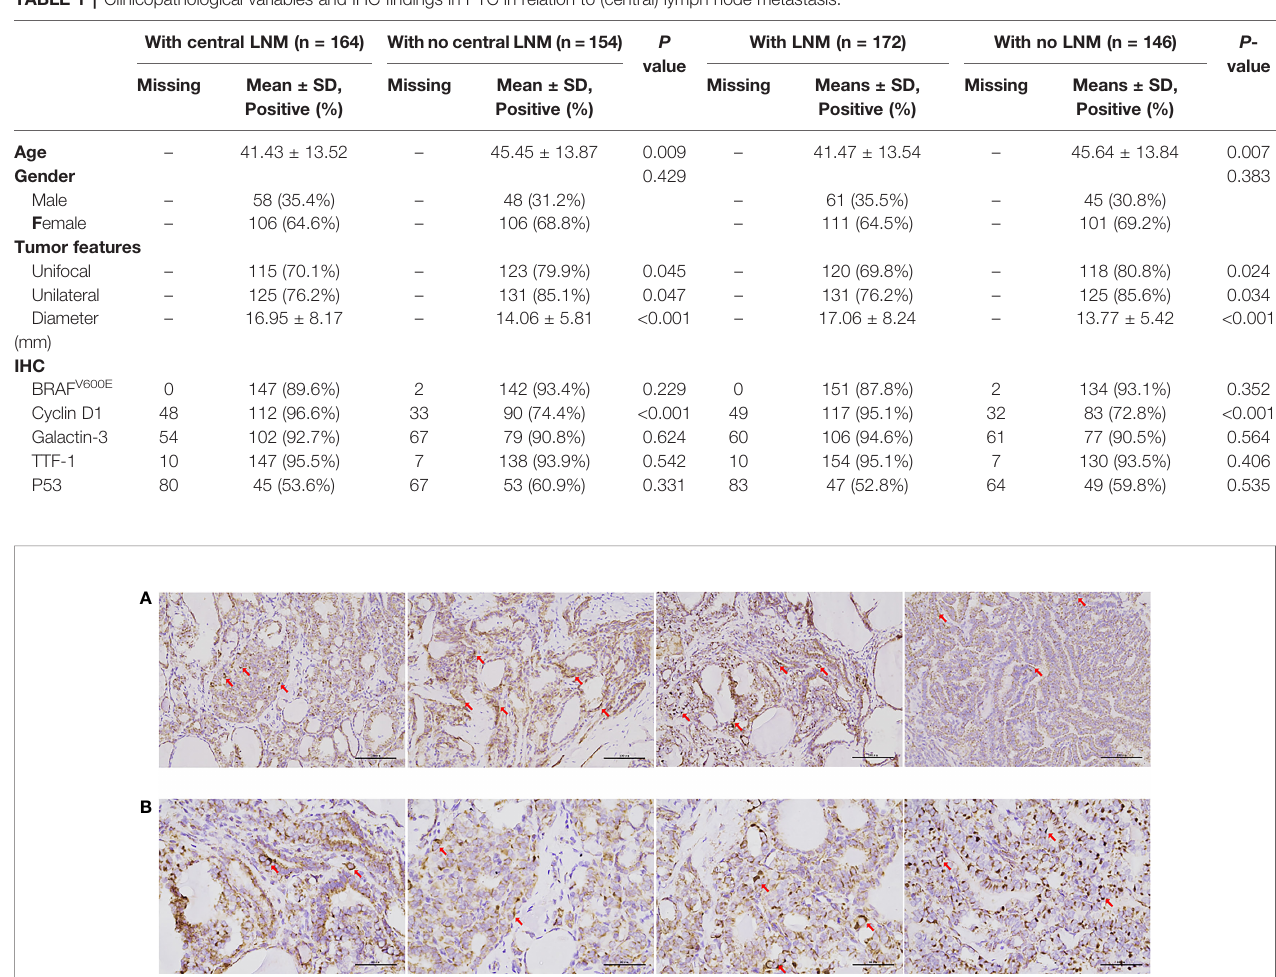
TABLE 1 | Clinicopathological variables and IHC fi ndings in PTC in relation to (central) lymph node metastasis.